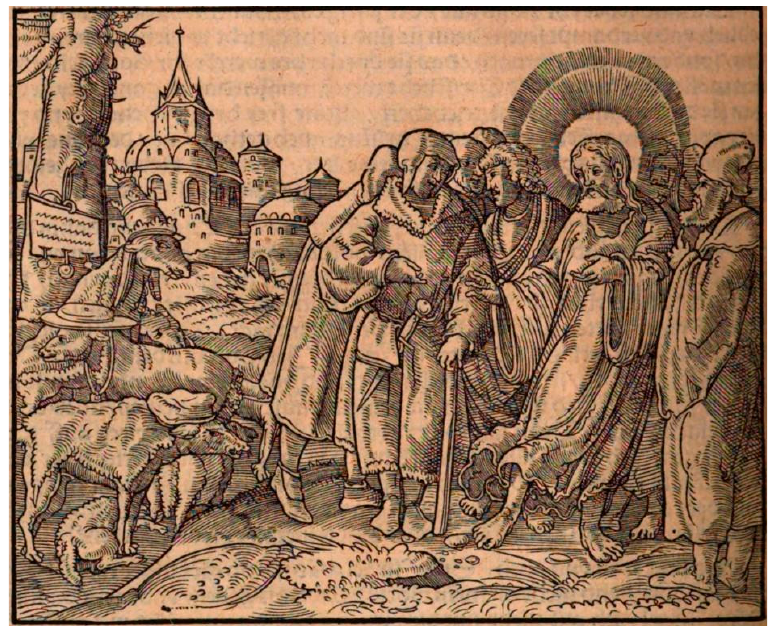
Figure 2. Warning against false prophets , ca. 1529, in (Luther 1530), part 2, fol. [C]LXIIv (Augsburg, Staats- und Stadtbibliothek, 2 Th Pr 144# (Beibd. 1, urn:nbn:de:bvb:12--bsb11204848-8; NoC-NC/1.0). Staats- und Stadtbibliothek, 2 Th Pr 144# (Beibd. 1, urn:nbn:de:bvb:12–bsb11204848-8; NoC-NC /